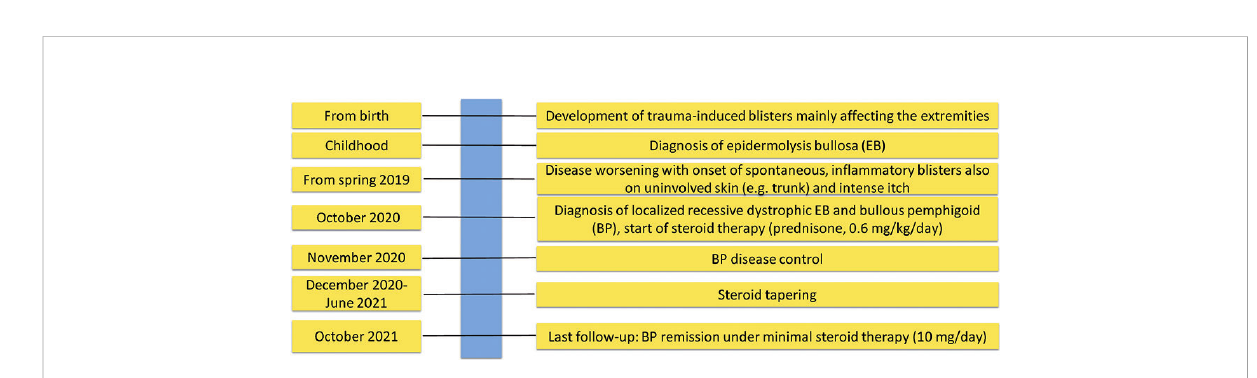
FIGURE 4 Timeline of patient ’ s clinical history, and diagnostic and therapeutic